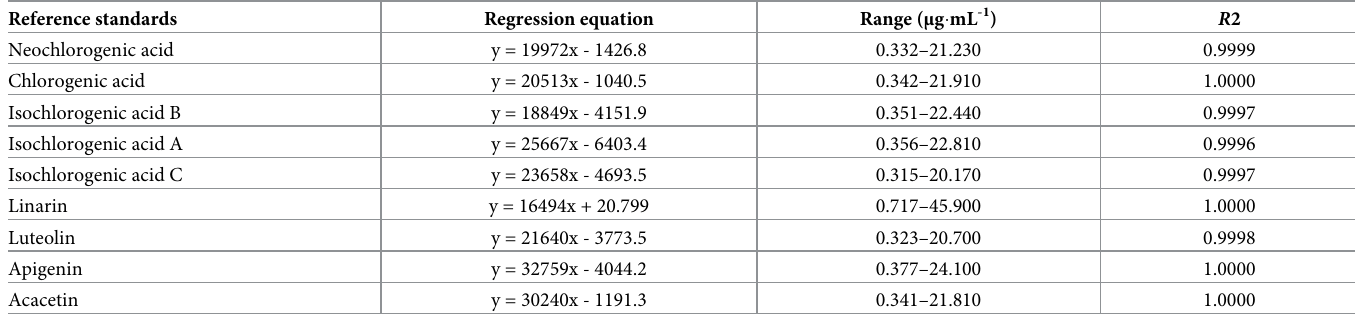
Table 3. Linearity assessment of the nine reference standards under UPLC conditions.